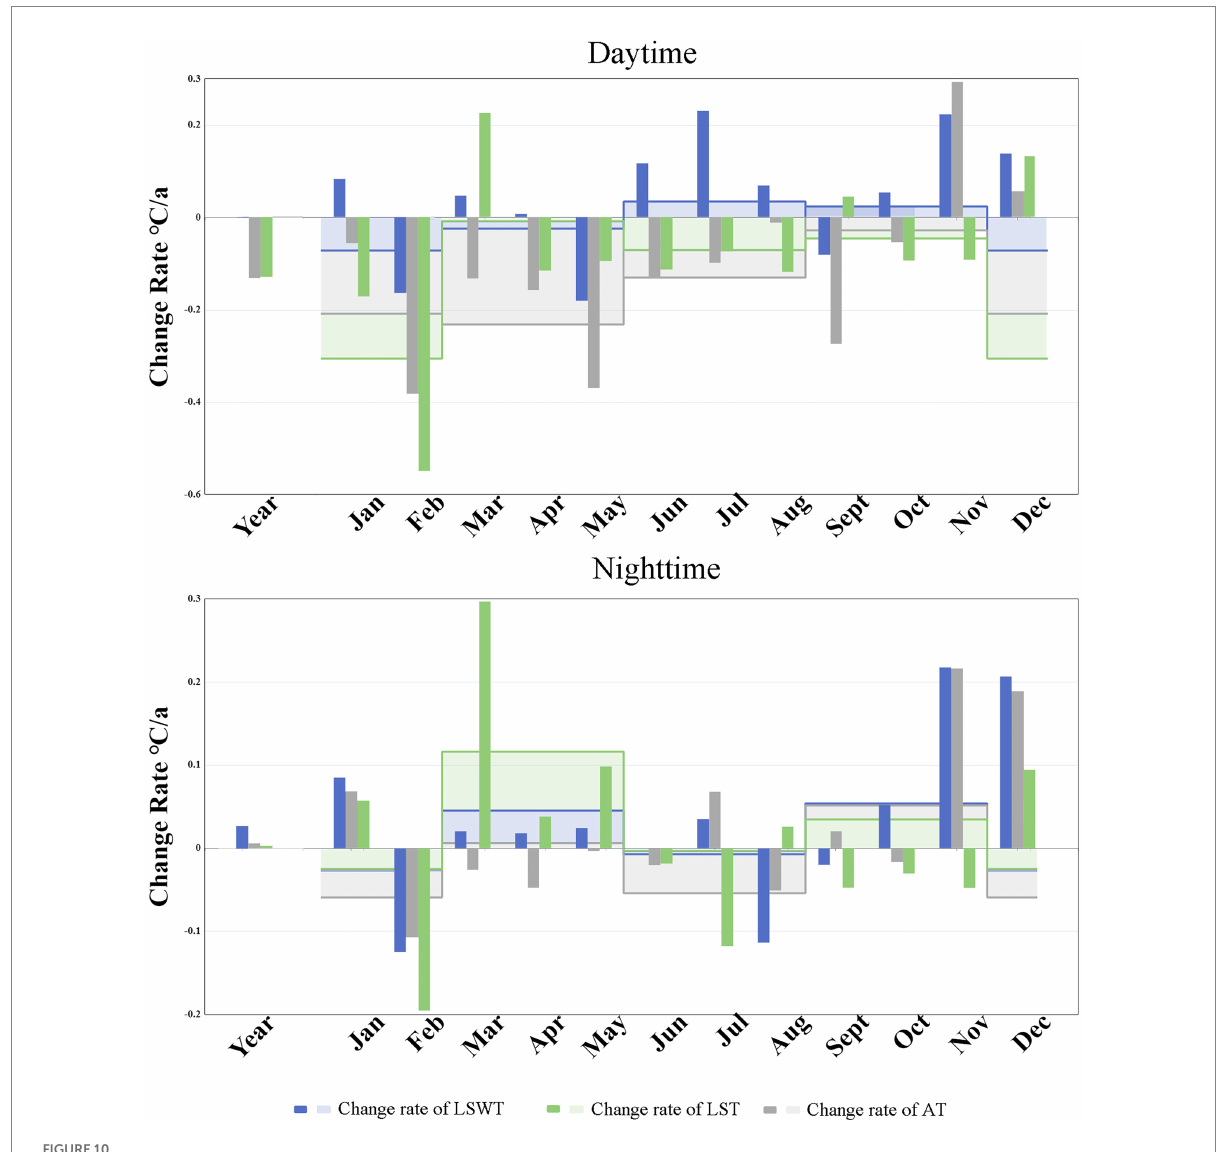
FIGURE 10 Temperature trends of AT, LSWT, and LST from 2009 to